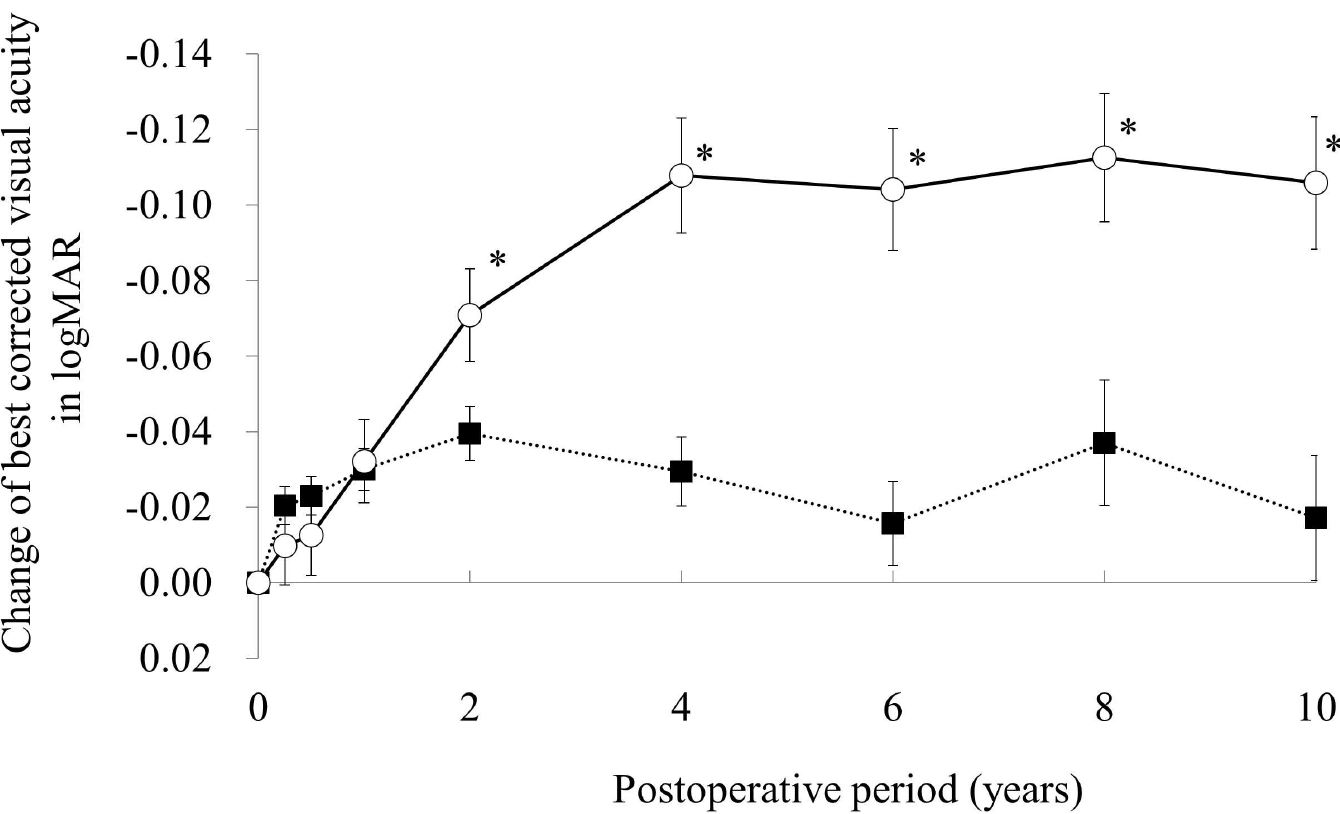
Fig 3. Time courses of the averageand 95% confidence intervals of change of best spectacle-corrected visual acuity in the laser in situ keratomileusis (closed square) and photorefractive keratectomy(open square) groups. * p < .05.